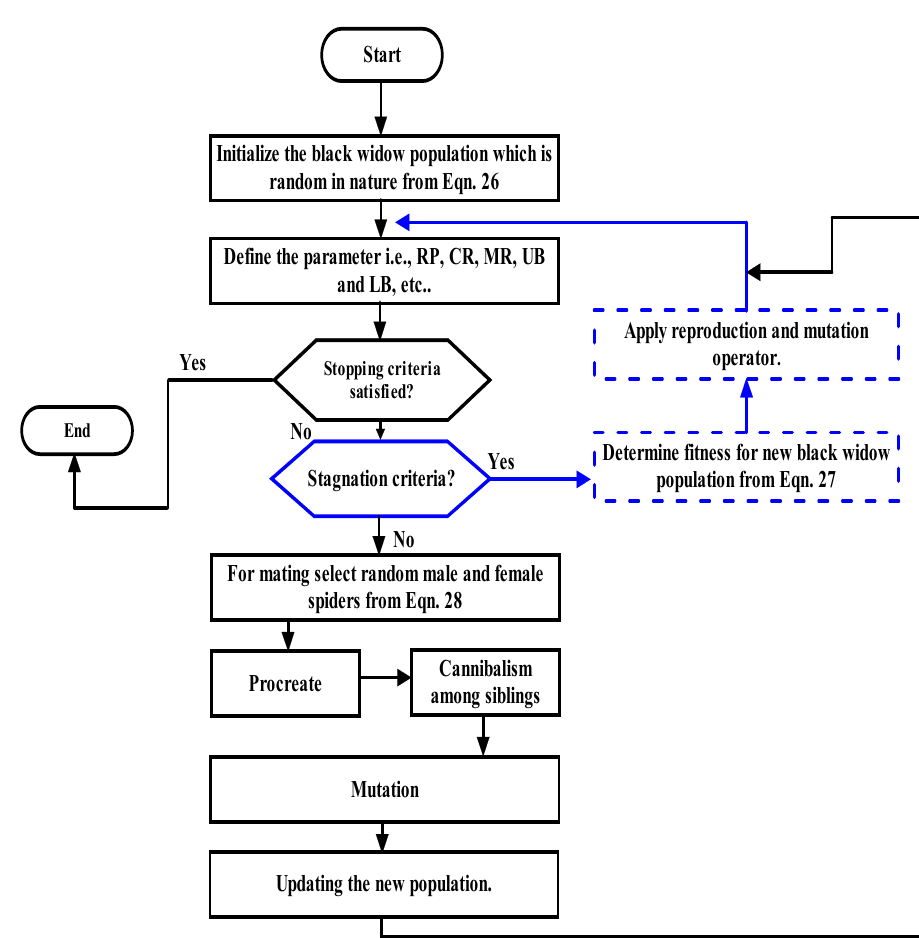
Figure 9. Flowchart of the proposed MOBWO algorithm.